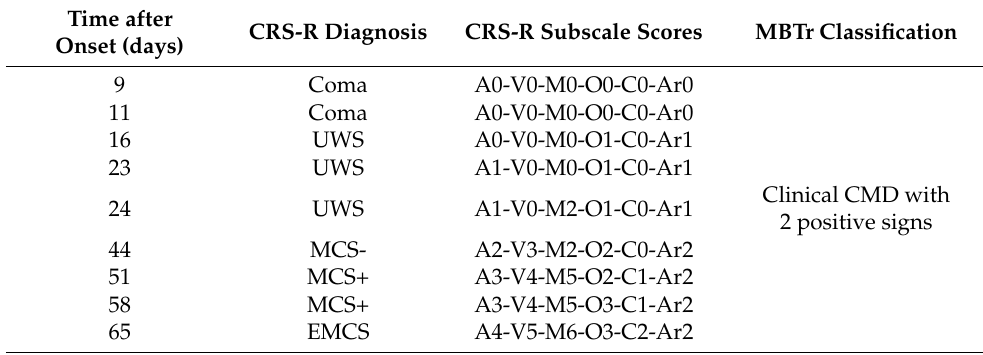
Table 1. Clinical features and